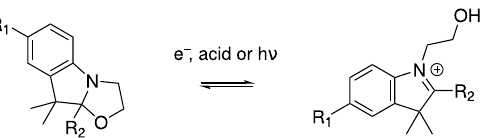
Figure 1. The benzozalooxazoline (BOX) multi-addressable NLO switch (see, e.g., [33]). The form of the left- (right-) hand side is referred to as the “closed” (“open”) form, displaying the smallest (largest) β value. To enhance the response of the open form, R 1 is generally an acceptor group (or it is the grafting point in the case of multi-state switches), while R 2 is ideally a donor.